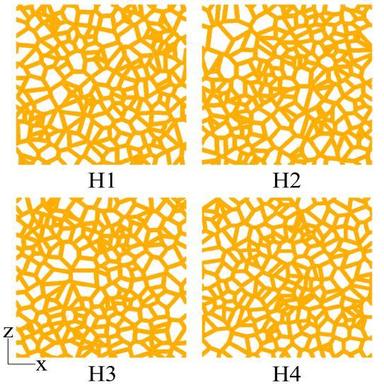
The four instances of the periodic honeycomb structures, called H1–H4. Figure adopted from with permission from Elsevier.